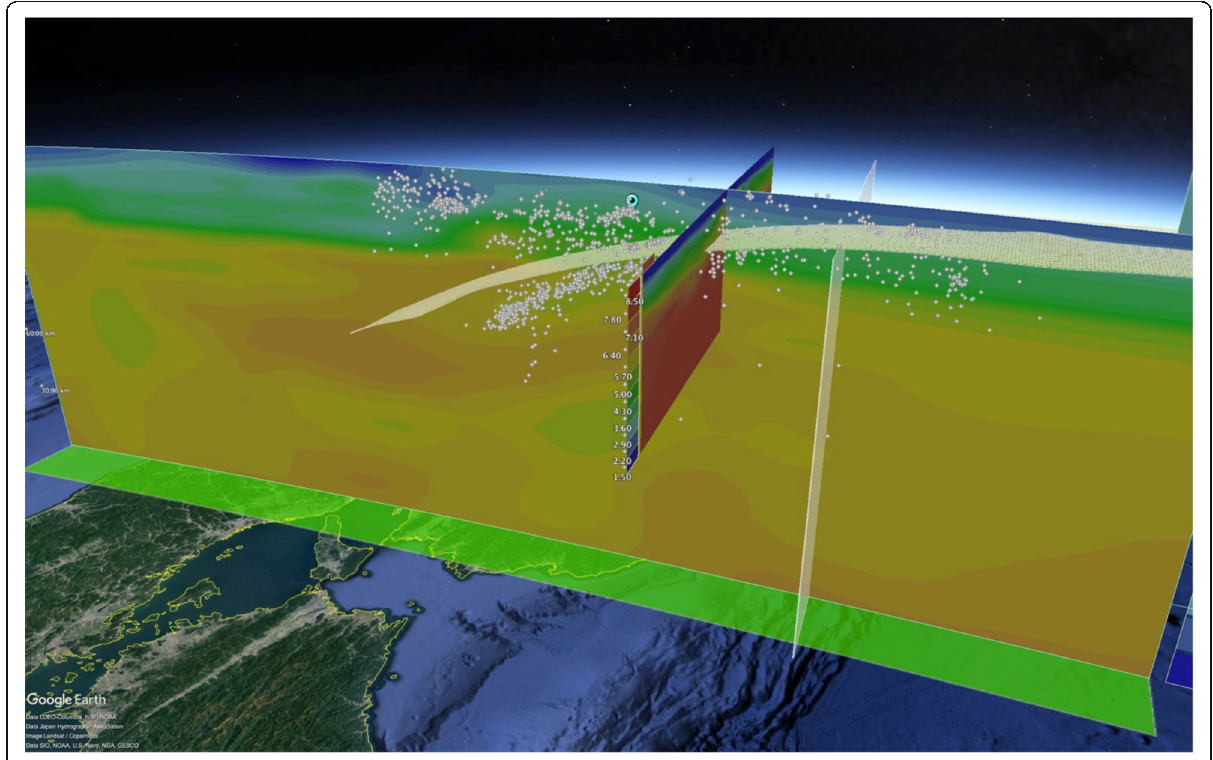
Fig. 5 Visualization of various seismic structural models under the Nankai Trough. The cross section of the 3D seismic velocity model is from Nakajima and Hasegawa (2007), the 3D plate geometry model from Nakanishi et al. (2018), the 2D plate geometry and seismic velocity models from Kodaira et al. (2006), and the hypocentral distribution from Akuhara et al. (2013). The green rectangle on the Earth ’ s surface shows the user- defined search area. Differences between the individual models are notable; for example, hypocenters located at the surface of the subducting slab are consistently deeper than the top of the slab in the 3D plate geometry